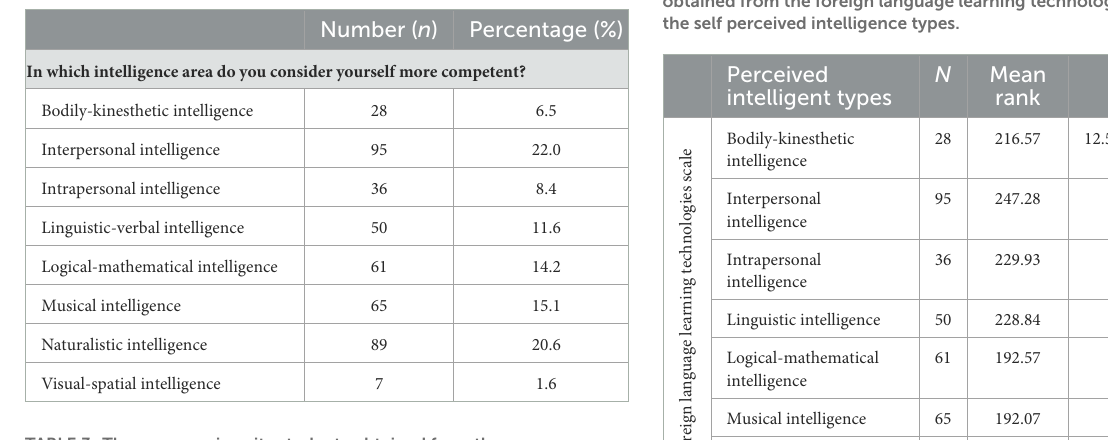
TABLE 3 The scores university students obtained from the twenty-first-century kills scale and the foreign language learning technologies scale.